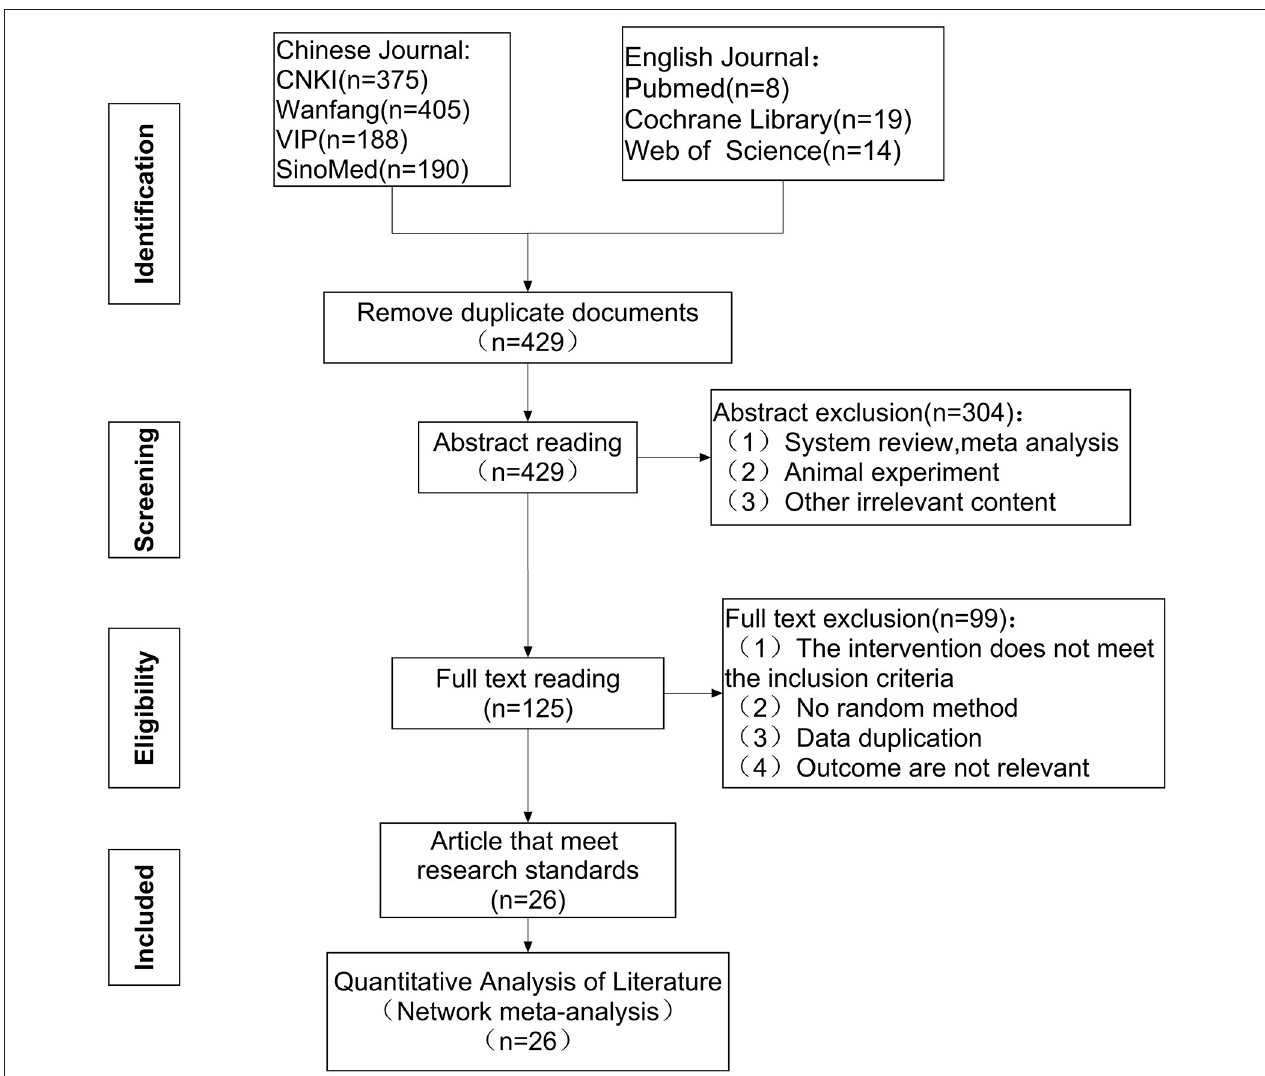
FIGURE 1 | Flow diagram depicting the selection process of eligible studies. CNKI, China national knowledge infrastructure; VIP, Chinese Scientific Journals Database; SinoMed, Chinese Biomedical Literature Service System; n, number of publications.